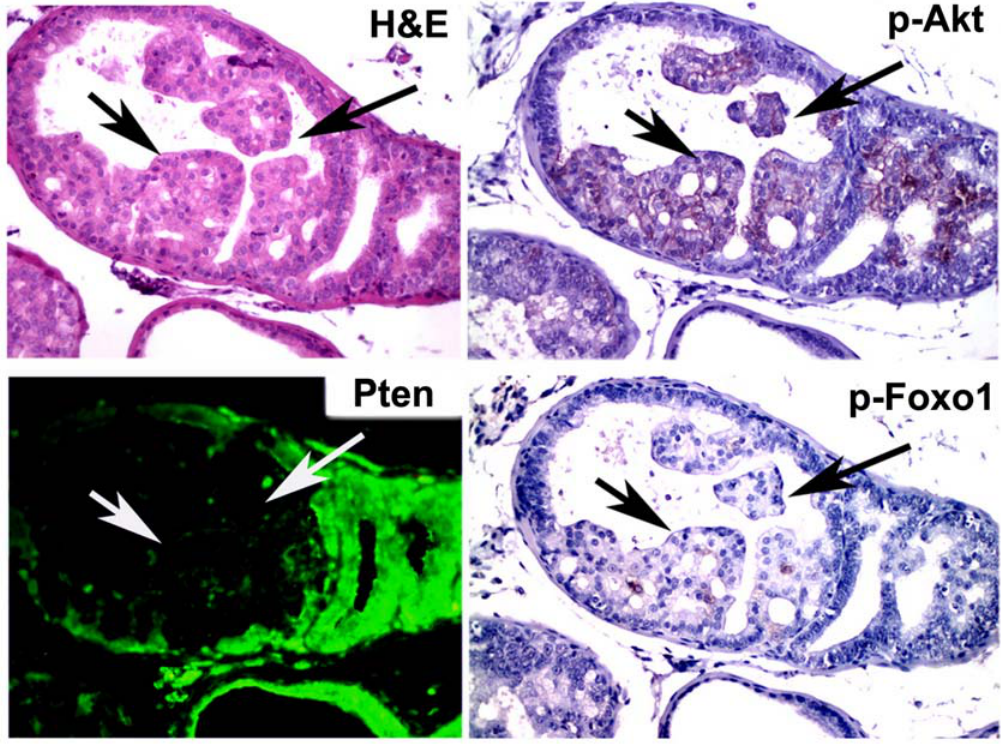
Figure 4. Focal loss of Pten expression in PIN lesions of PbCre4;Z-MYC;Pten f/ + mouse prostate. In focal PIN lesion (arrows), Pten protein expression is lost and phosphorylation of Akt and Foxo1